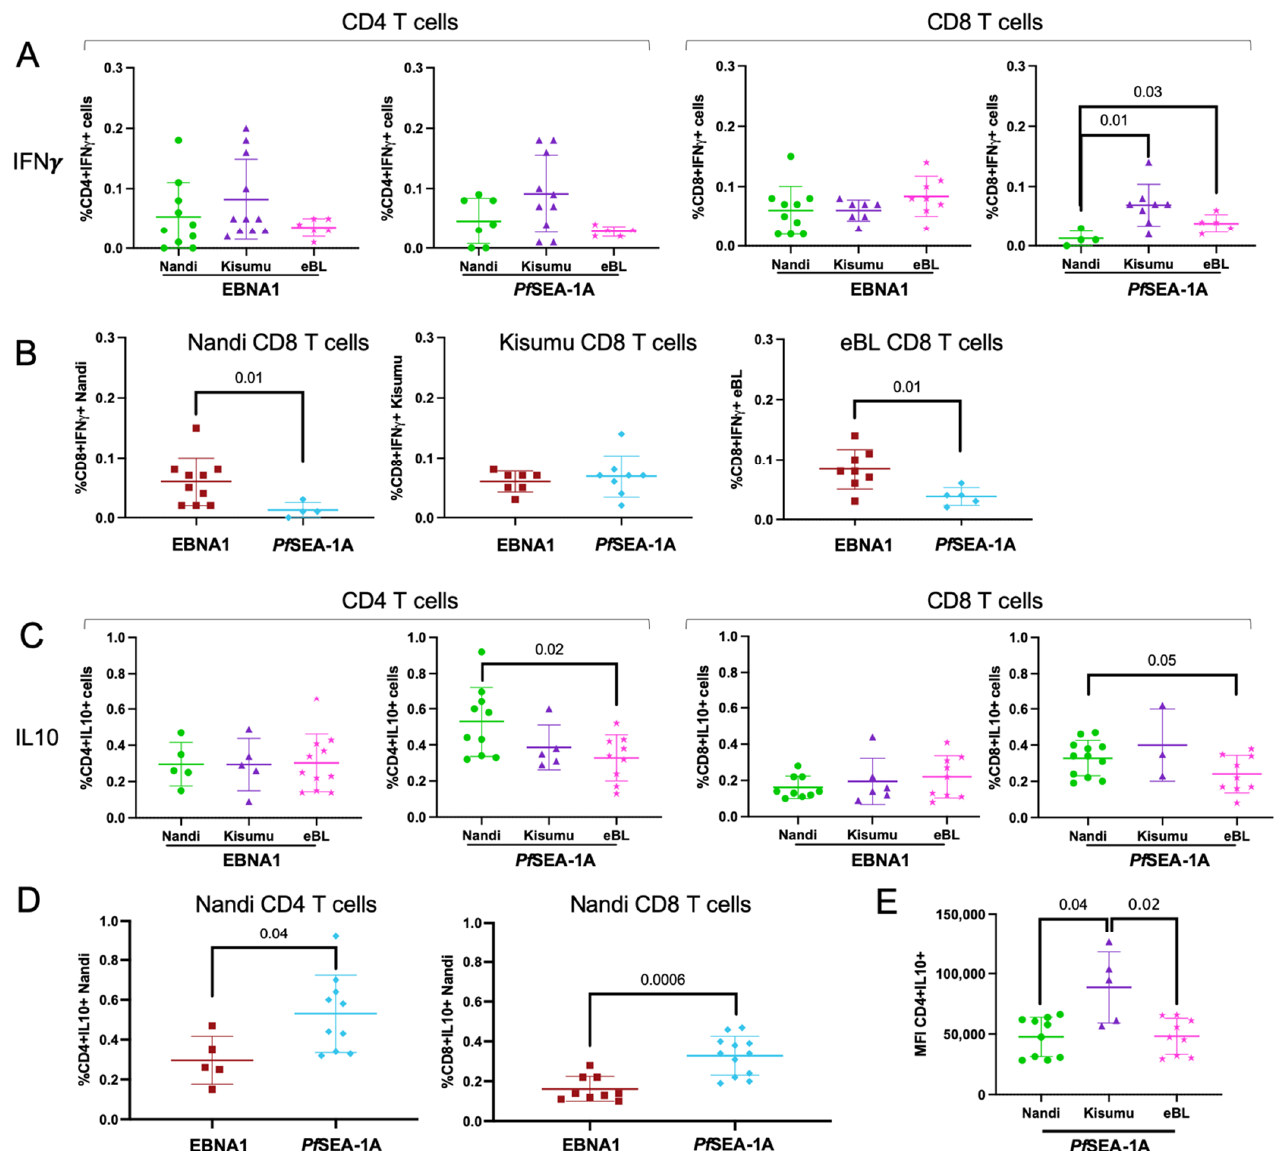
Figure 2. Comparison of cytokine-expressing CD4 + and CD8 + T cell frequencies across study groups. ( A ) EBNA1 and Pf SEA-1A responses were measured as a percentage of total CD4 + and CD8 + cells expressing IFN- γ and compared across the different groups of children: Nandi (green circle), Kisumu (purple triangle) and eBL (pink star). ( B ) IFN- γ + CD8 + T cell responses to EBNA1 (red square) and Pf SEA-1A (blue diamond) were compared within Nandi (left), Kisumu (middle), and eBL (right) children. ( C ) EBNA1 and Pf SEA-1A responses were measured as the percentage of total CD4 + and CD8 + T cells expressing IL-10 and compared across the different groups of children: Nandi, Kisumu and eBL. ( D ) IL-10 response to EBNA1 and Pf SEA-1A were compared for CD4 + (left) and CD8 + (right) T cells from Nandi children. ( E ) Comparison of IL-10 + expression intensity from CD4 + T cells (geometric mean fluorescent intensity, MFI) after Pf SEA-1A stimulation across groups of children: Nandi, Kisumu and eBL. Mann–Whitney or Wilcoxon p -values are indicated as well as the mean with standard deviation (SD).